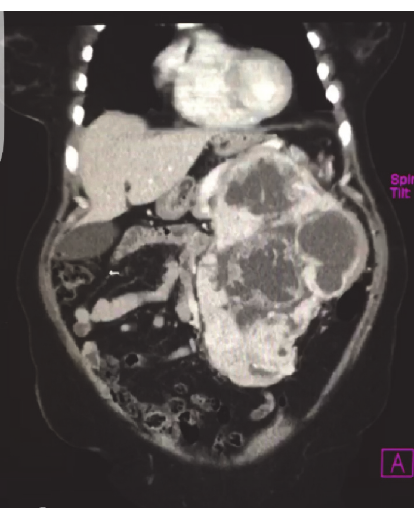
Figure 1: CT scan showing a 23cm, thick-walled, multicystic mass occupying most of the left upper quadrant of the abdomen.